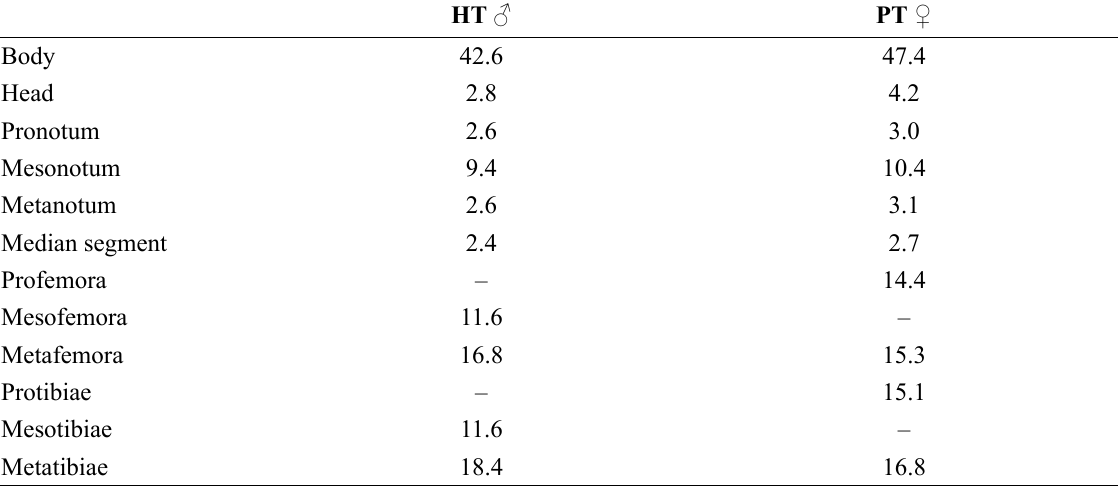
Table 5. Measurements (mm) of Capuyanus magwilangi sp. nov. HT = holotype; PT =